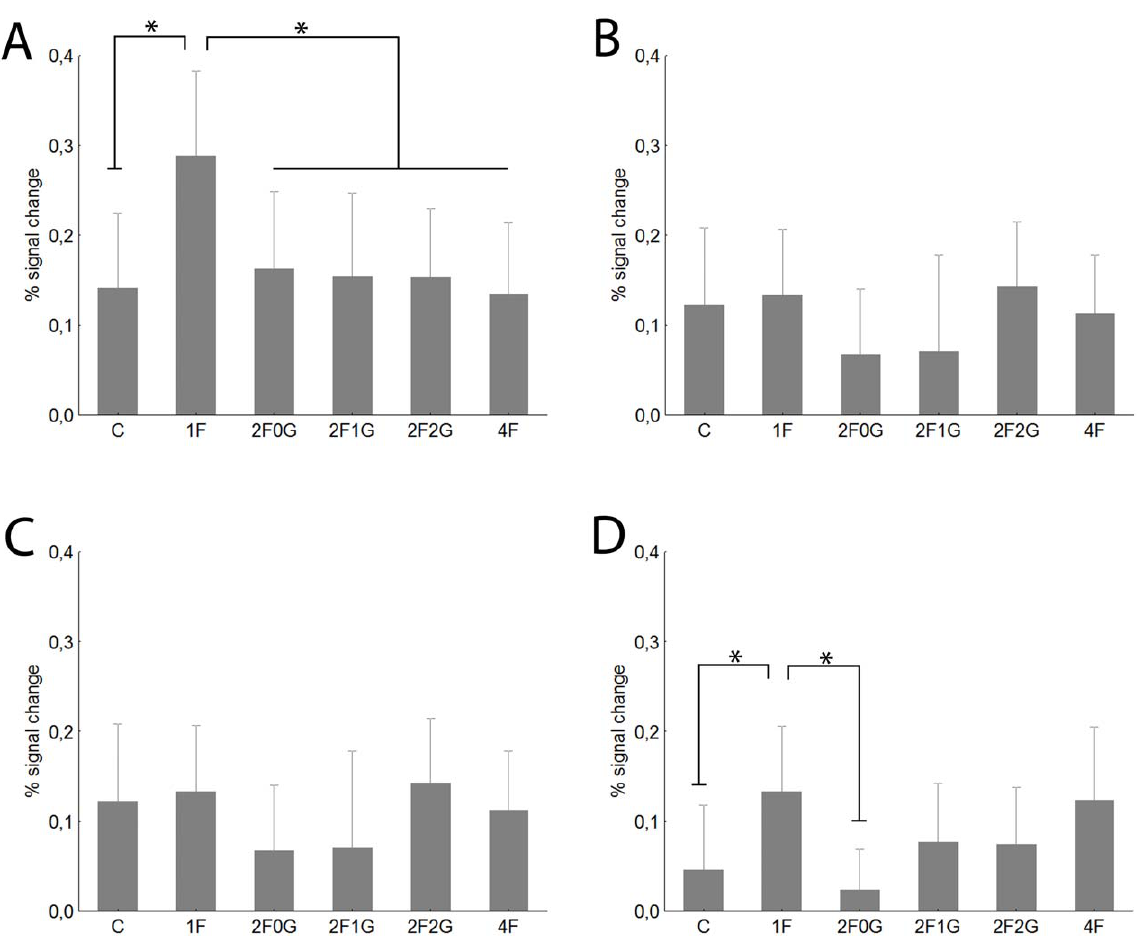
Figure 6. Average peak activation profiles ( ± standard error) of the LOC. Right LOC contralateral (A) and ipsilateral stimulation (B). Left LOC contralateral (C) and ipsilateral (D) stimulation. For conventions see Fig. 2.